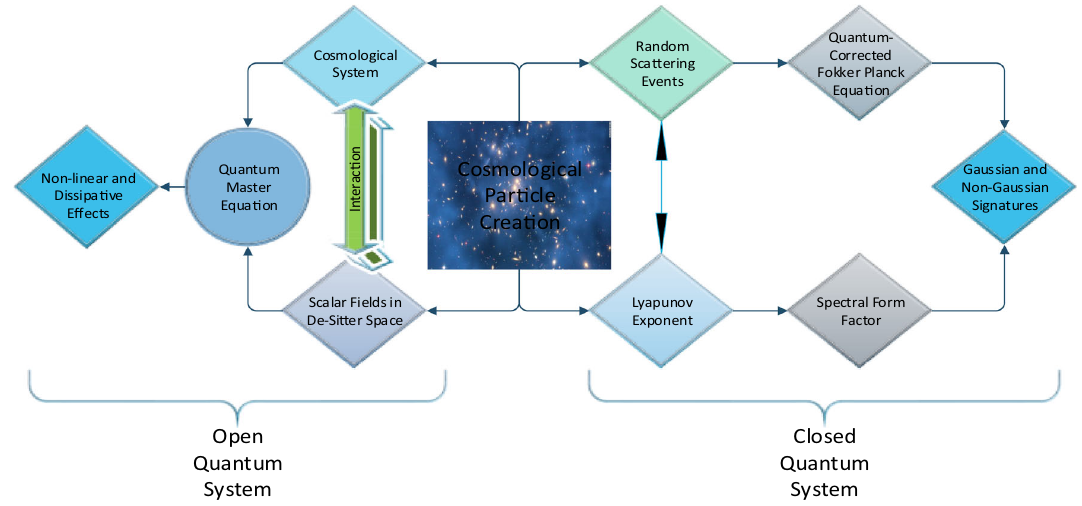
Fig. 2 Overview of the computational strategy of the whole paper and how different parts are inter-related ing in reheating) evolves with time stochastically due to